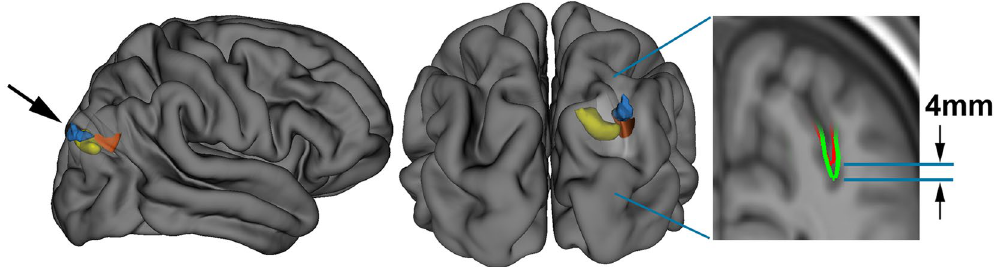
Figure 2. NeanderScore related brain changes in the intraparietal sulcus. Structural variation of the intraparietal sulcus (IPS) related to percentage of Neanderthal-derived SNPs (NeanderScore). Left and middle show lateral and posterior views of the right IPS on the average brain surface, illustrating the anatomical convergence of the associations of NeanderScore with greater sulcal depth (orange; p < 0.05 FWE-corrected), gray matter volume (blue; p < 0.005), and white matter volume (yellow; p < 0.005). Right shows a coronal slice (y = − 72 mm) through the IPS where there was a sulcal depth difference of 4 mm between the 30 individuals with highest (blue line) and lowest (red line) NeanderScore. Findings are depicted on the average brain of all 221 individuals included in the study and underlie the maximal skull findings shown in Fig. 1